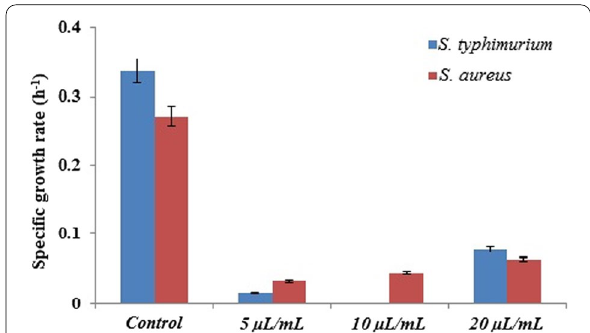
Fig. 6 Specific growth rate of S. typhimurium MDC1759 and S. aureus MDC5233, cultivated without (control) and with addition of different concentrations of GS Ag NPs (p < 0.05)